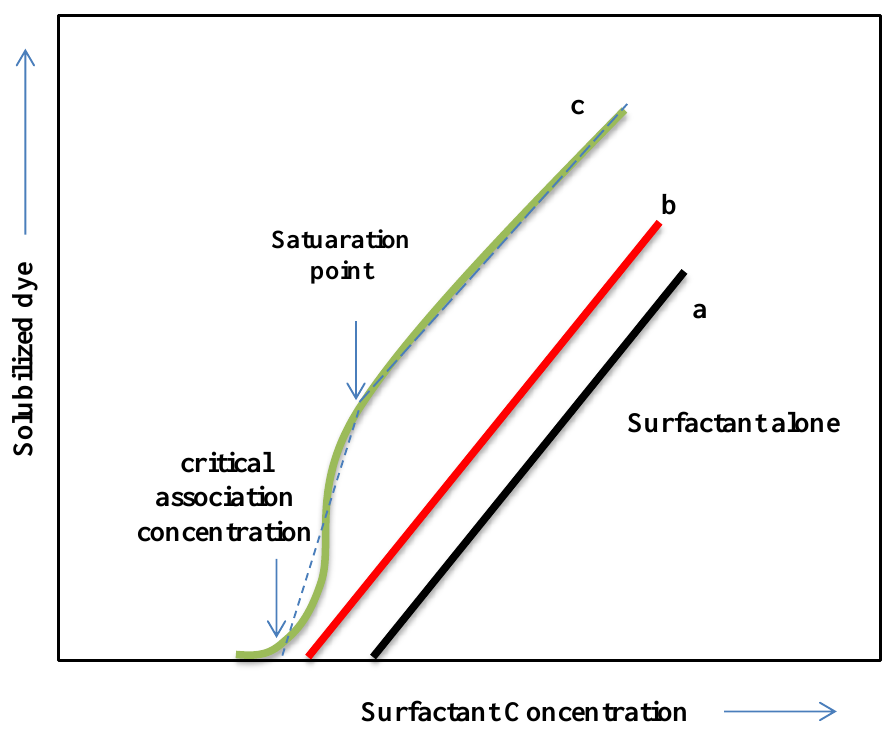
Figure 12. Solubilization of a water insoluble dye by surfactant-polyelectrolyte mixtures can take different paths. See text for explanation of the